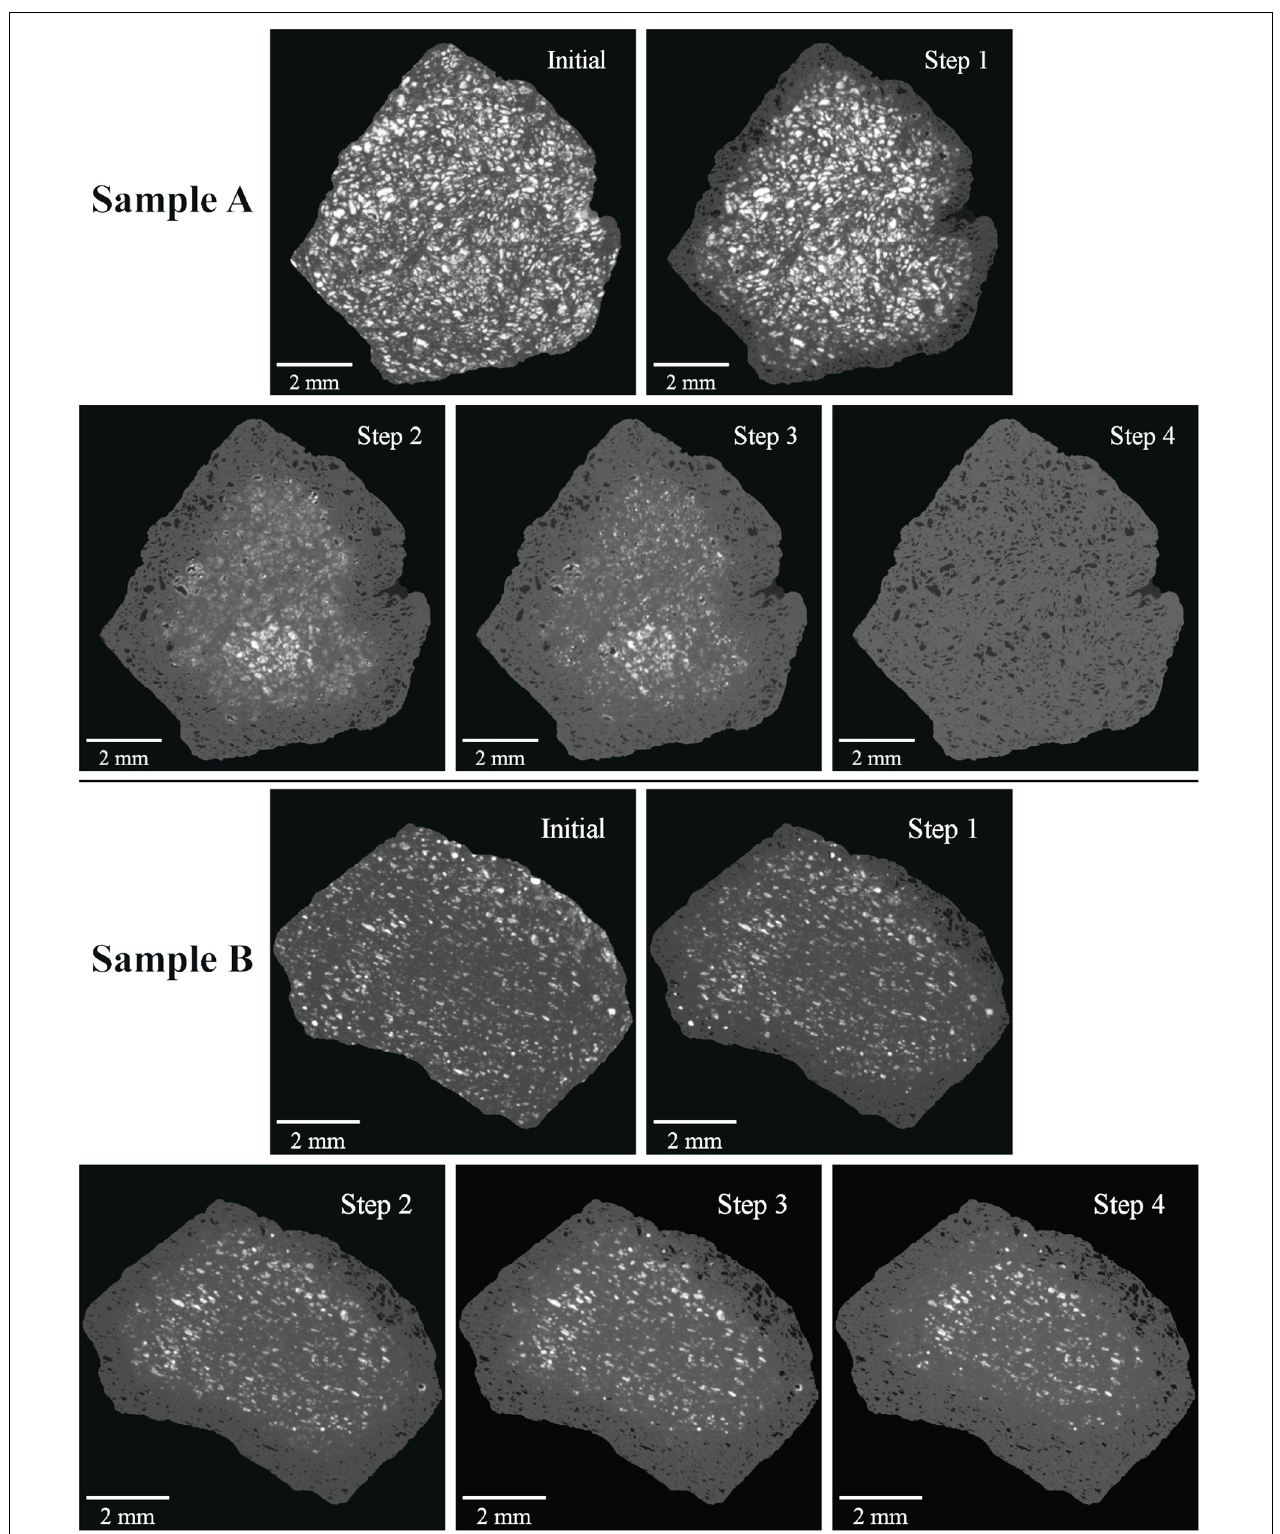
FIGURE 2 | Example XCT slices from sequential acid leaching steps of samples A (top) and B (bottom) after volume registration, resampling, and masking.